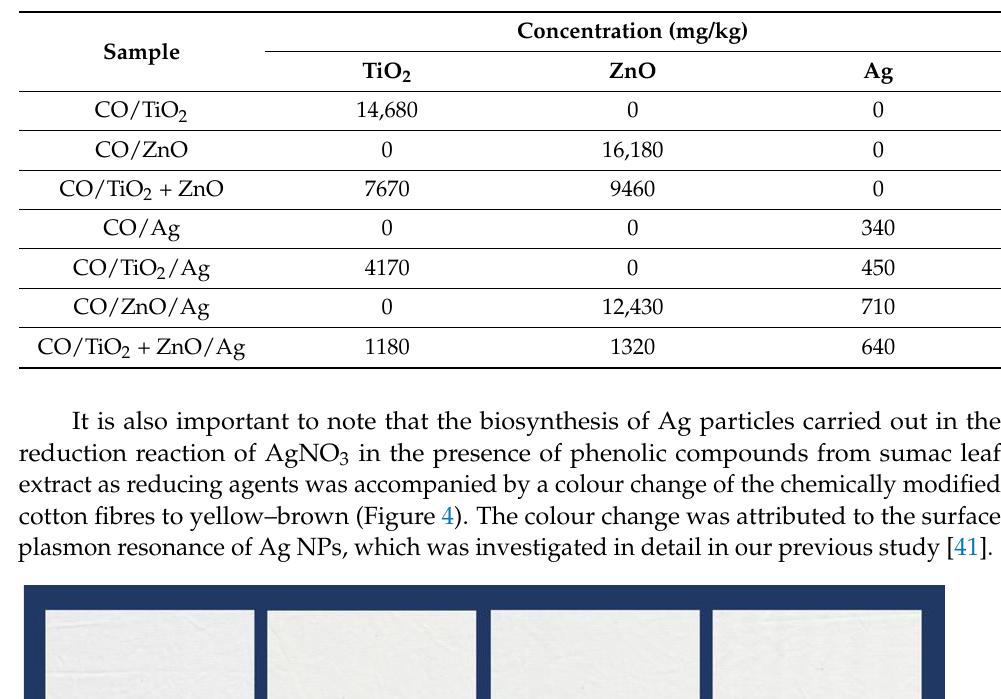
Table 1. Concentration of TiO 2 , ZnO and Ag on the studied samples.